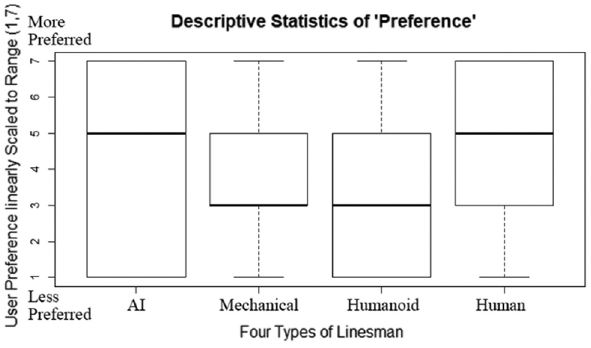
Figure 4: Preference levels of four types of